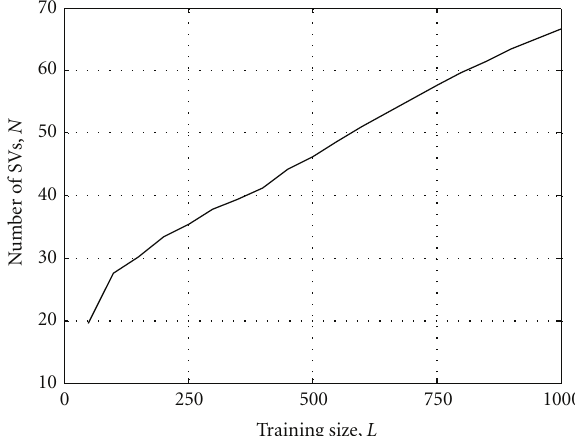
Figure 4: Correct rate of the SVM model with linear kernel for di ff erent C parameters, SNR = − 4dB, n = 5.